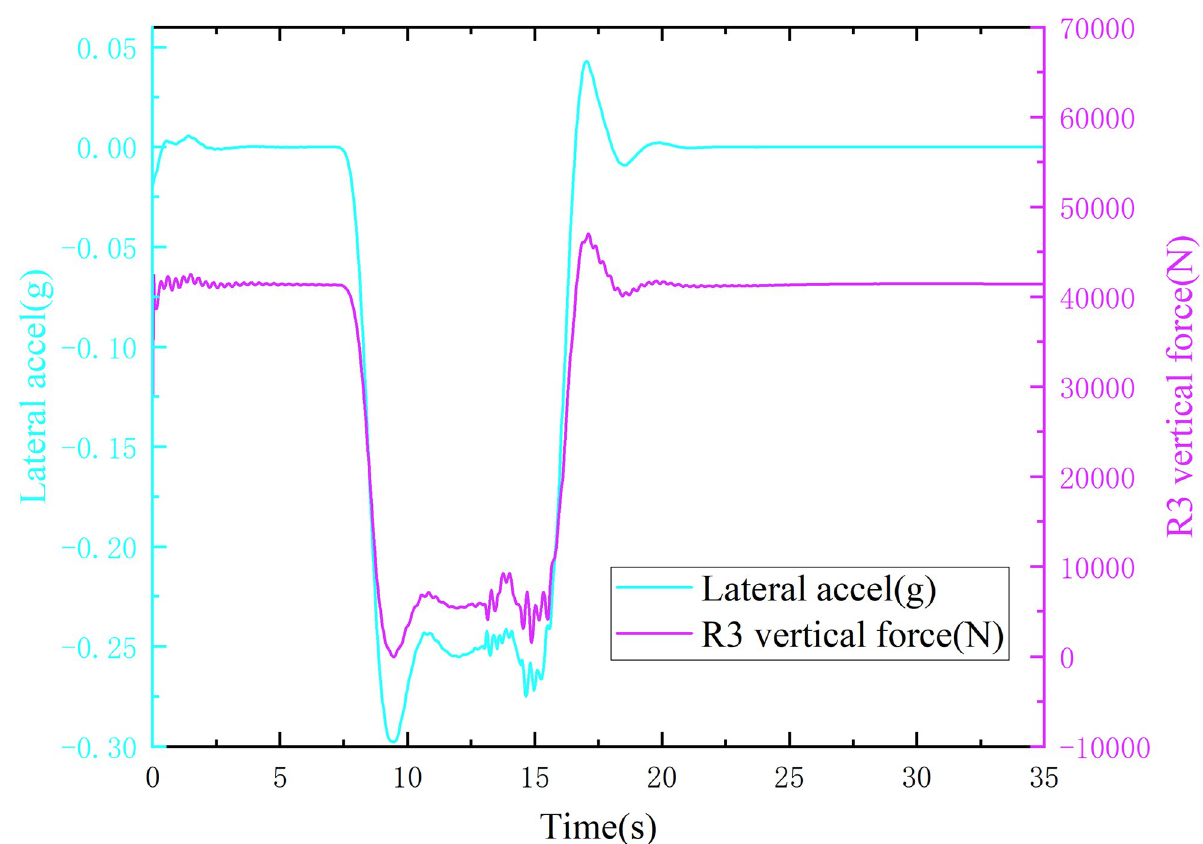
Fig 11. Lateral acceleration, right wheel vertical force curve (adhesion coefficient